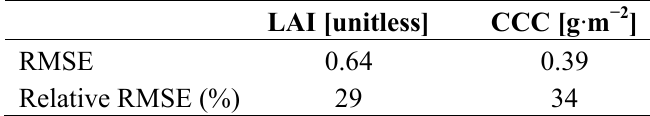
Table 3. RMSE and relative RMSE for RapidEye satellite sensor estimates of LAI and CCC variables and corresponding variables estimated in the field.